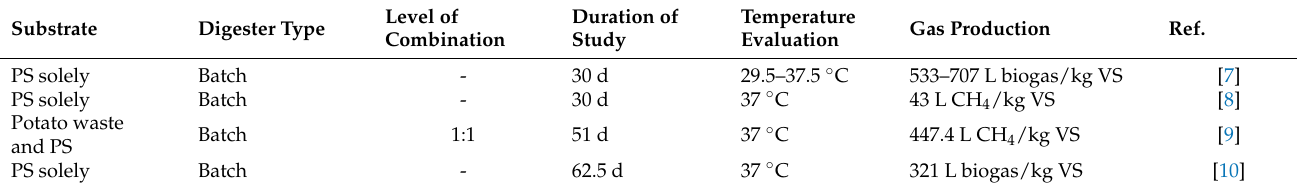
Table 1. Previous study showing the anaerobic digestion of